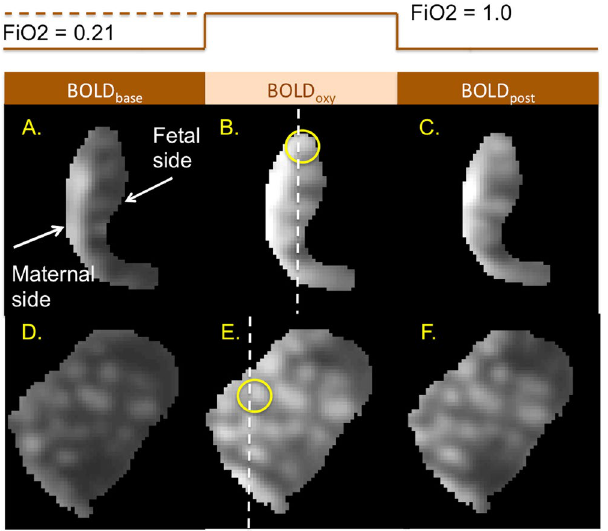
Figure 2. Example cross-sections of a placenta (gestational age 31.4 weeks) during different stages of maternal hyperoxia. ( A – C ) BOLD images of the same cross-section view, at baseline (Fraction of inspired oxygen, FiO2 = 0.21), during hyperoxia (FiO2 = 1.0), and post hyperoxia. Dashed line in B defines the plane of section for images ( D – F) . ( D – F ) cross-sectional views orthogonal to ( A – C ) respectively. Note multiple hyperintense regions in a cotyledon-like distribution. The temporal pattern of signal instensity from baseline to hyperoxia and back is further investigated in the cotyledon circled in B and E in Supplementary